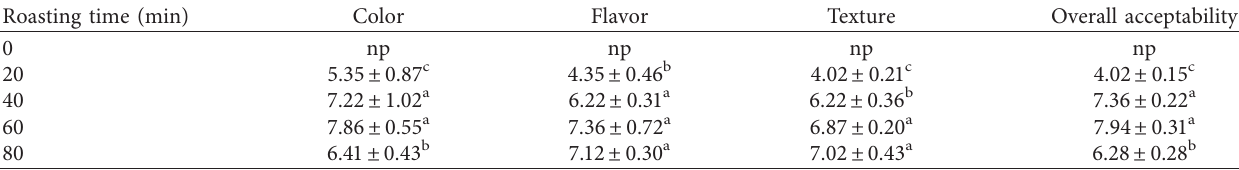
Table 1: Sensory score of giant salamander jerky as affected by roasting time.